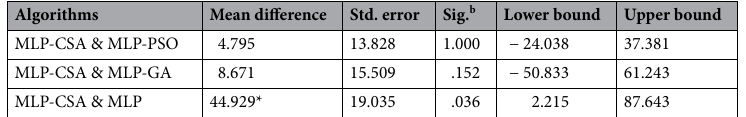
Table 5. Pairwise comparisons of all algorithms prediction error for the synthesized and coated TiO 2 . *The mean difference is significant at the .05 level. b Adjustment for multiple comparisons: Bonferroni.